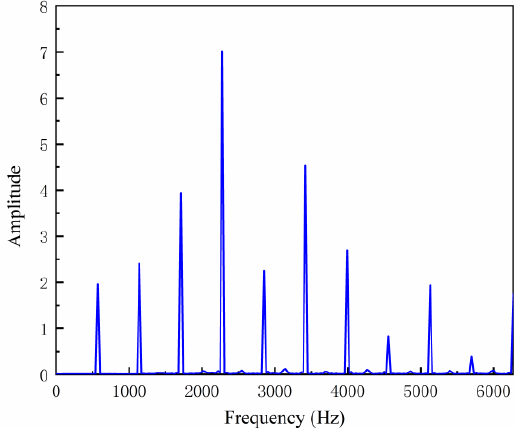
. y with 0.5 µ m wear. p